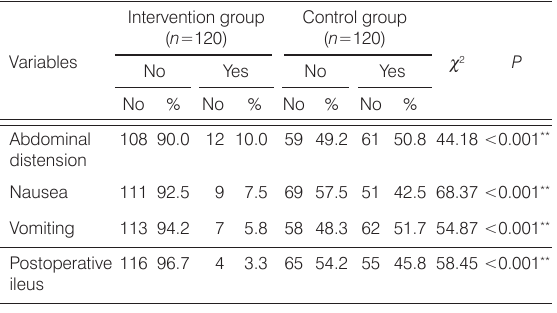
Table 5. Distribution of postoperative ileus symptoms among studied participants. Note: ** Highly statistically significant difference ( P <